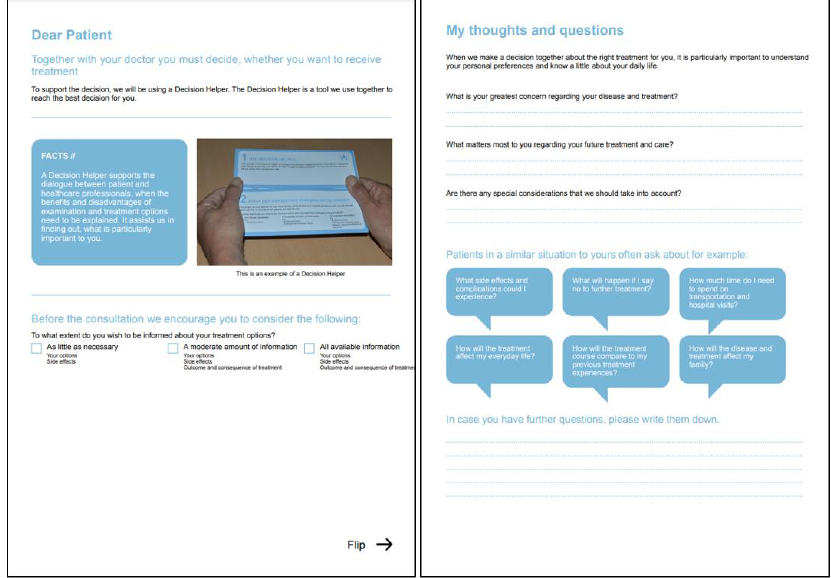
Figure 2. The preparation sheet to be handed out to patients before a decision-making consultation.